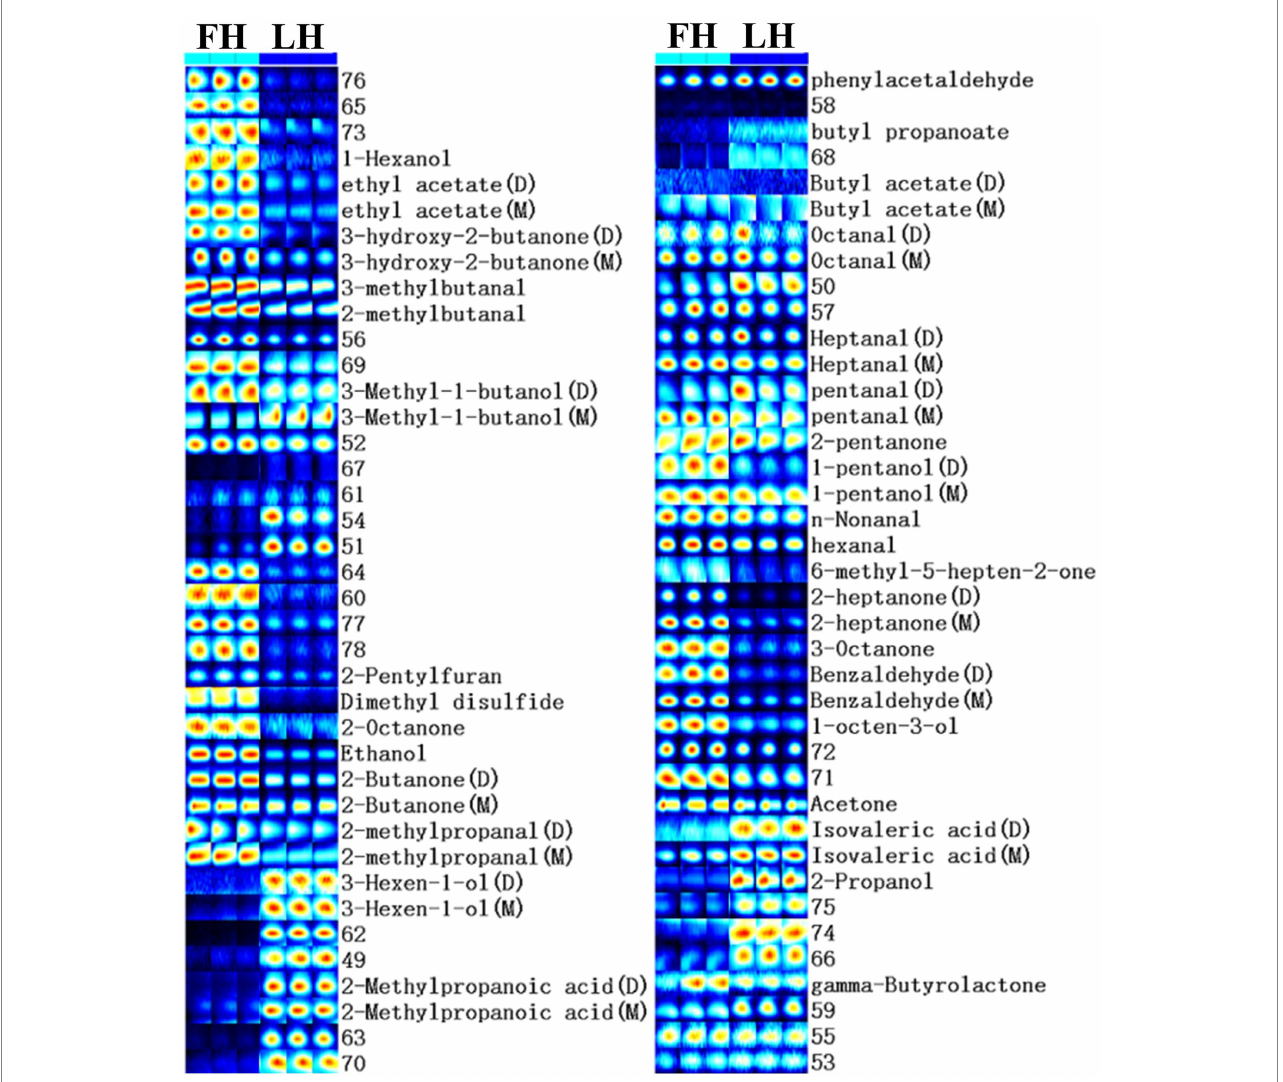
FIGURE 3 Gallery plot of characteristic flavor finger-print of Jinhua FH and LH determined by HS-GC-IMS. FH, fatty ham; LH, lean